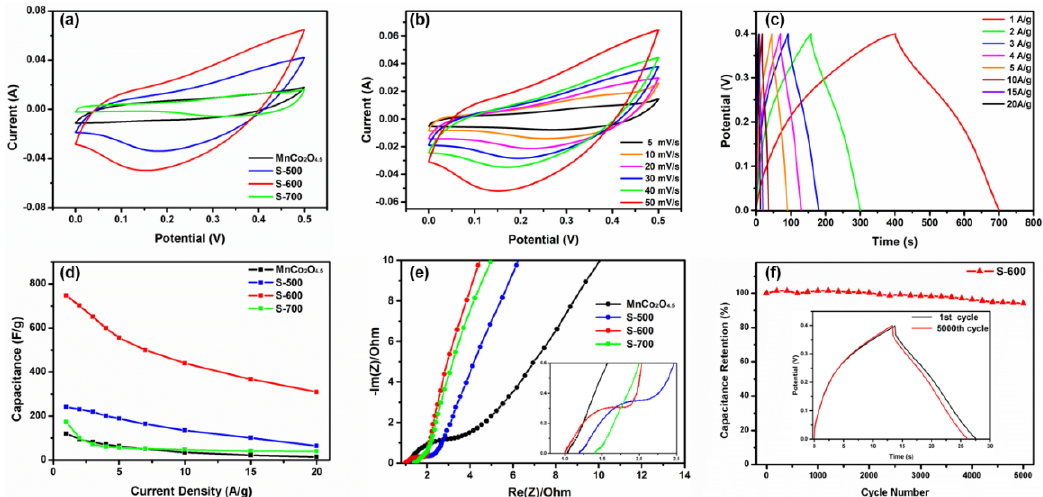
Figure 5. ( a ) Cyclic voltammetry (CV) curves of the pristine MnCo 2 O 4.5 , S-500, S-600, and S-700 at a scanning rate of 50 mV s − 1 ; ( b ) CV curves of S-600 at different scanning rates; ( c ) galvanostatic charge–discharge (GCD) curves of S-600; ( d ) Specific capacitances; ( e ) Nyquist plots; ( f ) Cycling performance of S-600 at 10 A g − 1 .